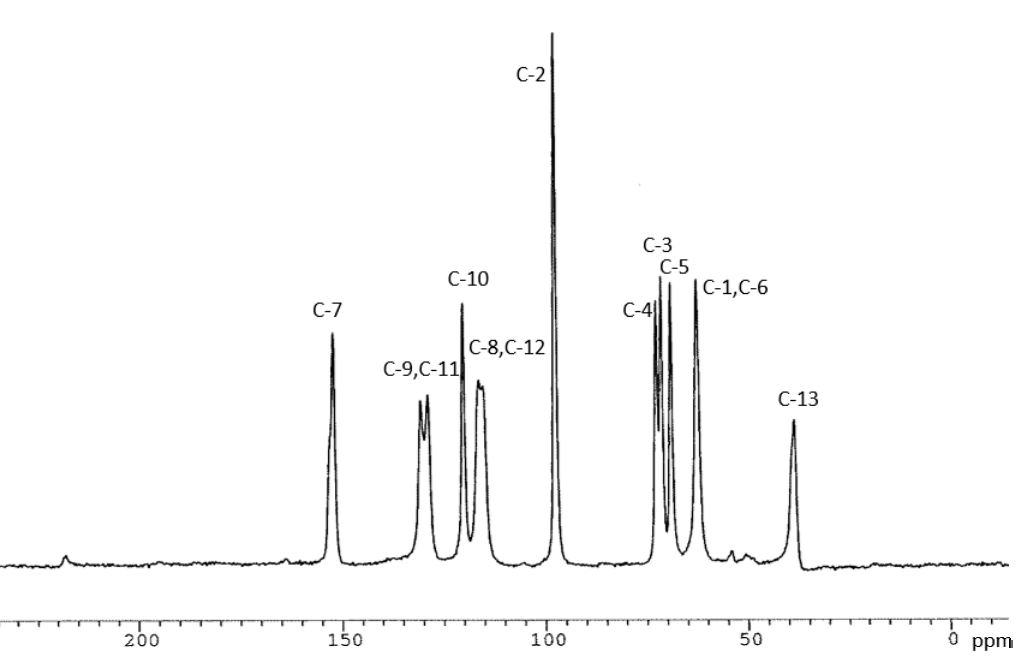
Figure 1. A solid-state 13 C-NMR spectrum of crystalline D -tagatose- N -methylaniline.